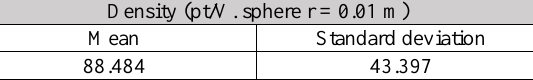
Table 3. Density of the point cloud (mean value and standard deviation).